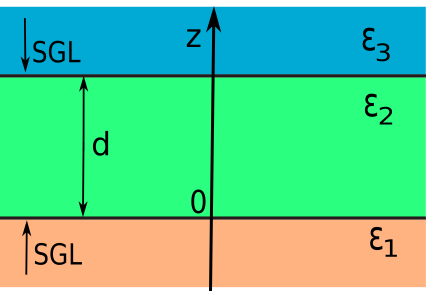
Figure 1. Scheme of a planar waveguide structure consisting of two single graphene layers (SGL) (ac- tive graphene) separated by a dielectric barrier layer of thickness d and covered with dielectric